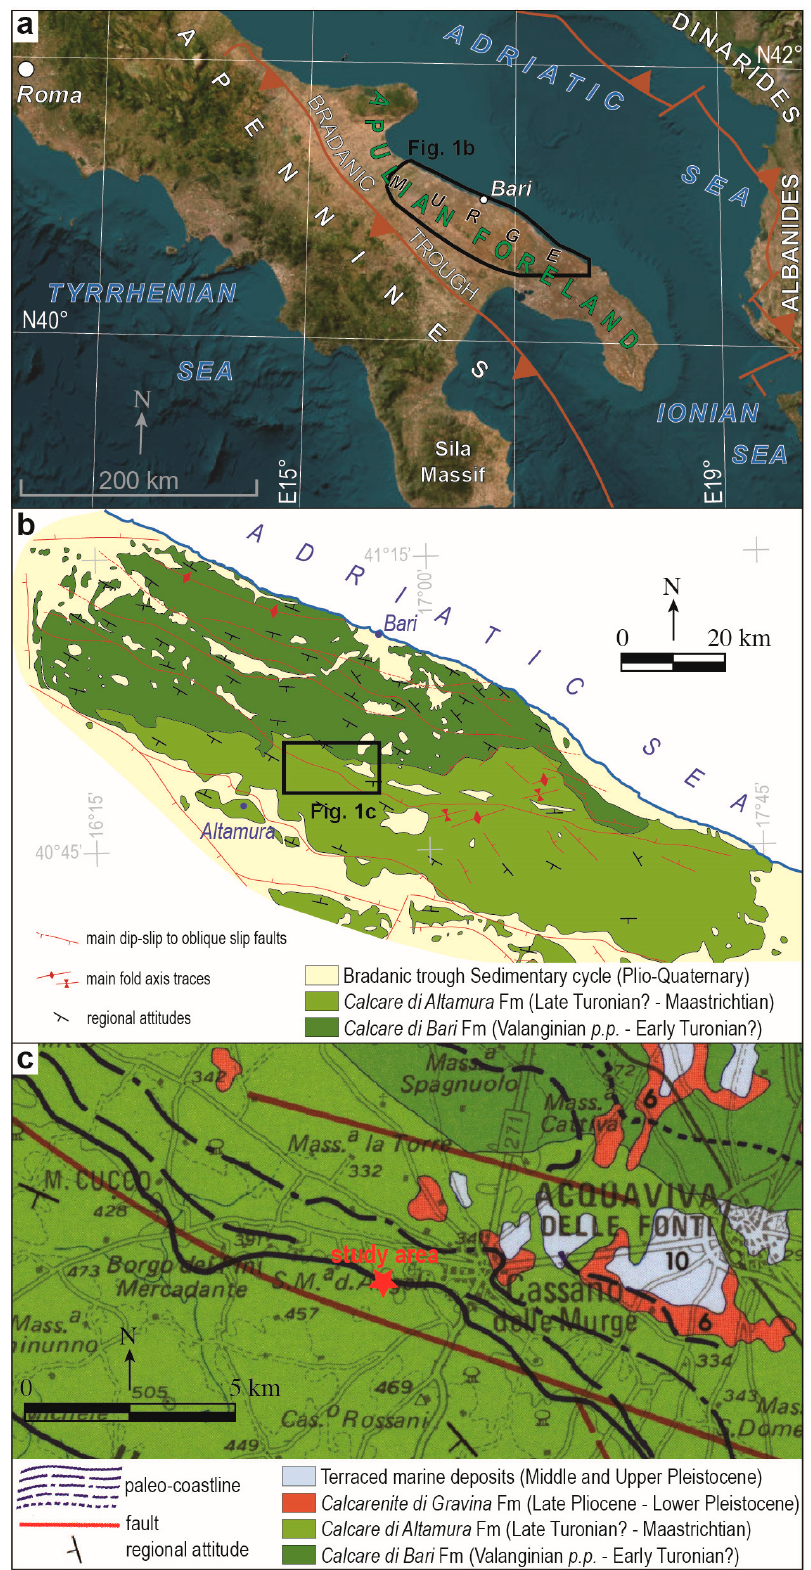
Figure 1. ( a ) Schematic structural map of the region around the Apulian Foreland (simpli fi ed after [24]); the thick closed line encloses the area in ( b ); ( b ) Geological and structural sketch map of Murge (modi fi ed after [11,25,26]); the rectangle with thick perimeter encloses the area in ( c ); ( c ) Geological map including the study area (i.e., the fi lled red star) (modi fi ed after [11]).